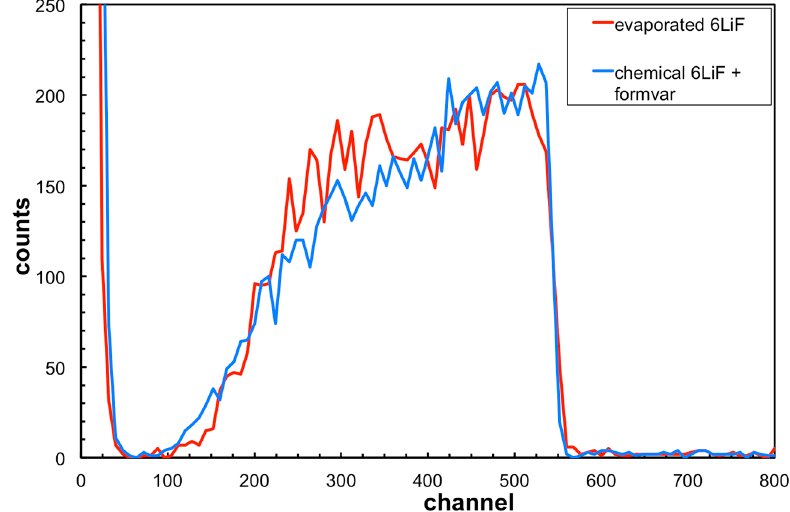
Figure 17. Comparison between two spectra obtained with a converter chemically deposited and a reference evaporated one. The nominal converter thickness was 16 µm. reference evaporated one. The nominal converter thickness was 16 µ